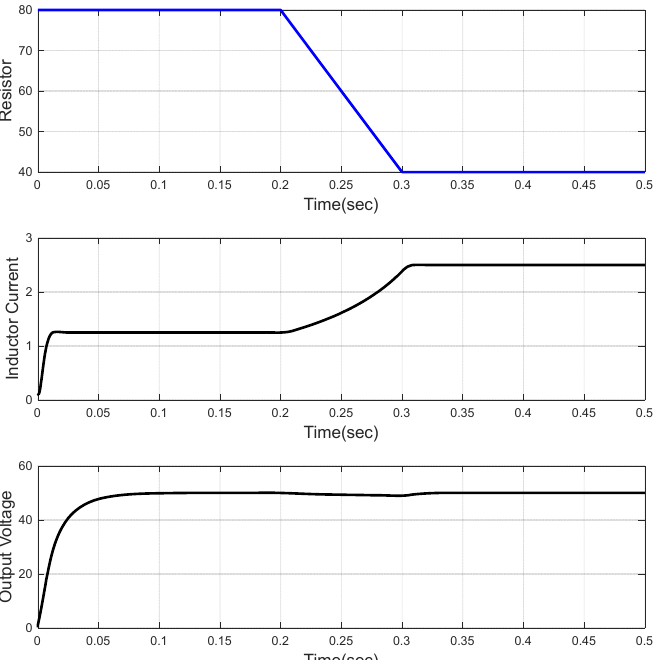
Figure 24. The behaviour of the inductor current and output voltage in the presence of measurement noise.